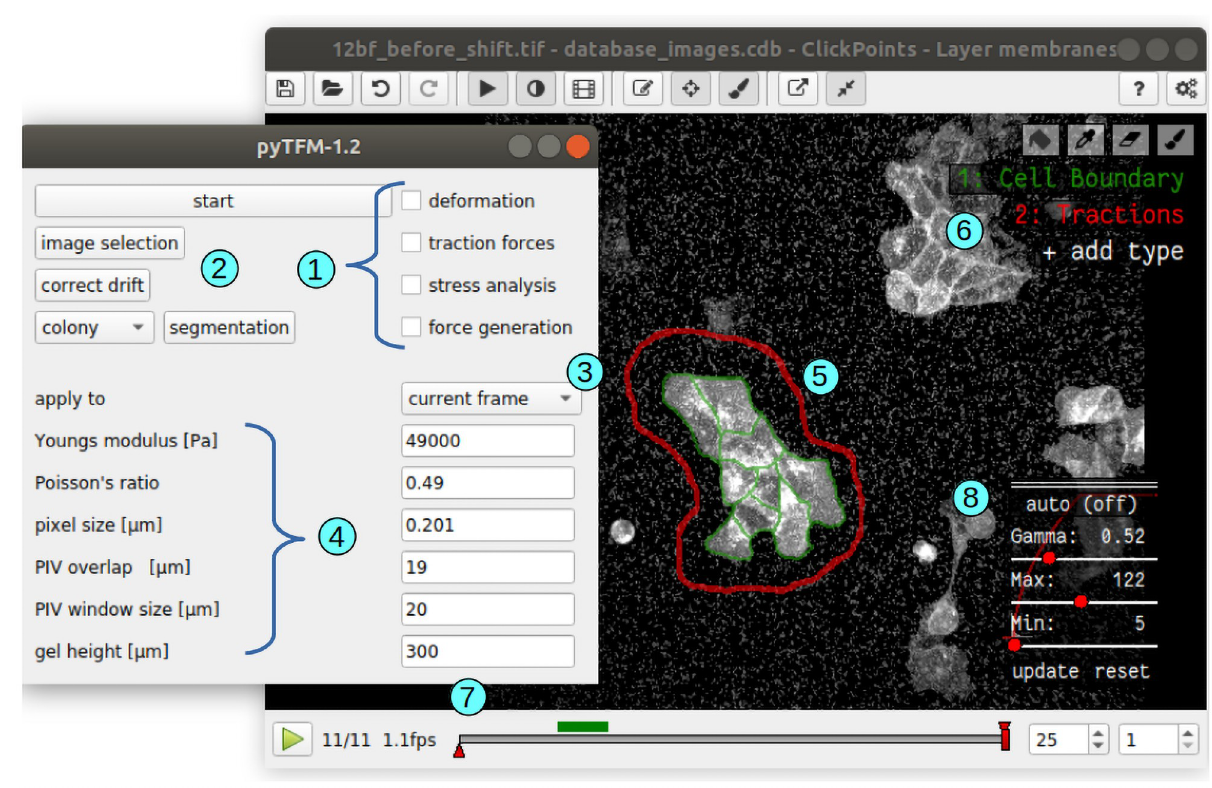
Fig 2. User interface of pyTFM. 1: Check boxes to select specific analysis steps. 2: Selection of input images, drift correction and semi automatic segmentation of cell borders. 3: Drop-down menu to select between analysing all frames in a database or analysing only the currently viewed frame. 4: Parameters for PIV and TFM. 5: User-selected region (red outline) and cell boundaries (green) for computing tractions, stresses, contractility, strain energy and line tensions. 6: ClickPoints tools to select the region and the cell boundaries by drawing masks. 7: ClickPoints navigation bar through frames. Layers are navigated with the Page Up and Page Down keys, and frames are navigated with the left and right arrow keys. 8: ClickPoints panel to adjust contrast and brightness of the image display. This is helpful for manually segmenting cell borders.